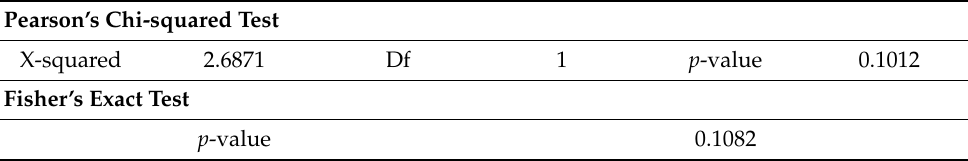
Table 4. Pearson’s Chi-squared Test and Fisher’s Exact Test for the variable